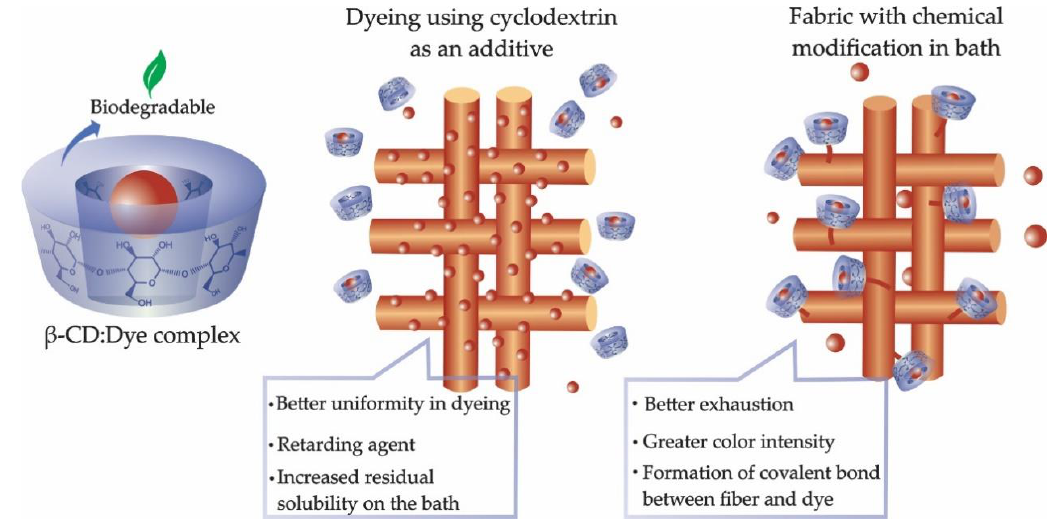
Figure 3. Use of cyclodextrins in dyeing.